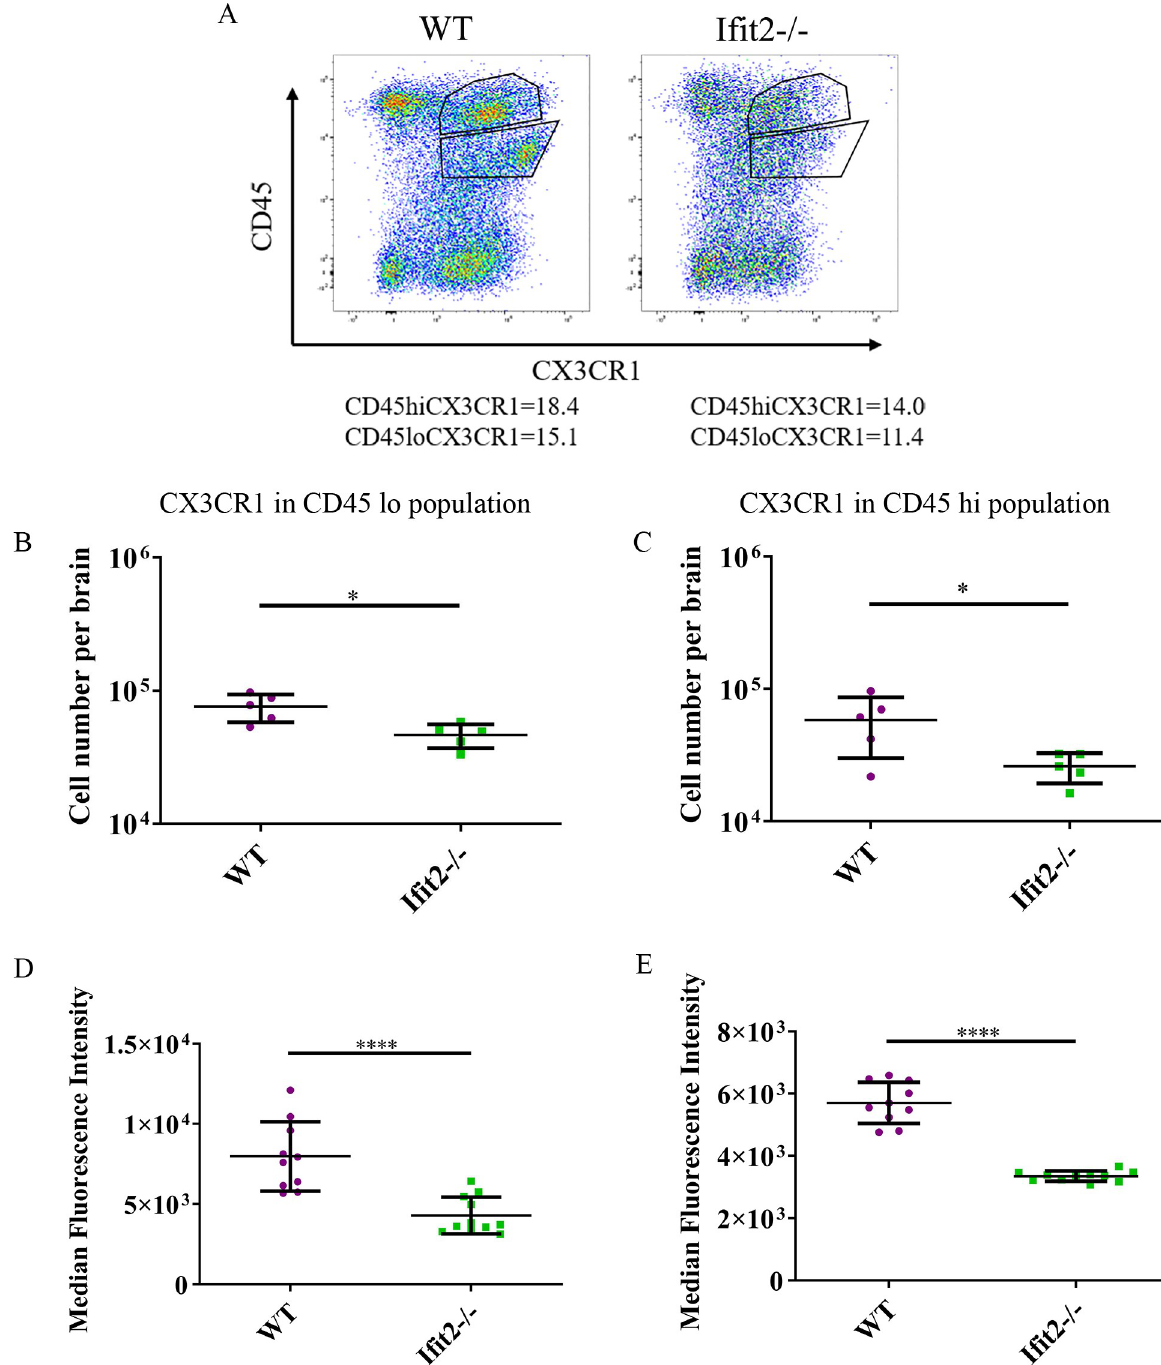
Fig 11. Ifit2 deficiency resulted in downregulation of CX3CR1 upon RSA59 infection. Brain derived cells from WT and Ifit2 -/- mice infected with RSA59 were stained for CD45 and CX3CR1 expression at 5 days p.i. Dot plots show gating and percentages of CD45 hi and CD45 lo populations as indicated. Dot Plot representation of the percentage of CX3CR1 expressing cells were gated from CD45 hi and CD45 lo populations in brain lysates at day 5 p.i. (Panel A; gated on live cells). Purple colour denotes WT and green colour denotes Ifit2 -/- mice. Panels B and C show absolute numbers of CX3CR1 expressing CD45 lo cells and CD45 hi cells as gated in Panel A from WT and Ifit2 -/- mice, respectively. Panels D and E show Median Fluorescent Intensity of CX3CR1 expressing CD45 lo and CD45 hi cells, respectively. The experiment is repeated 2–3 times with n = 5 for absolute number of cells and n = 10–11 for median fluorescent intensity. Asterix ( � ) represents differences that are statistically significant by Student’s unpaired t-test analysis. ( � P < 0.05, ���� P < 0.0001).